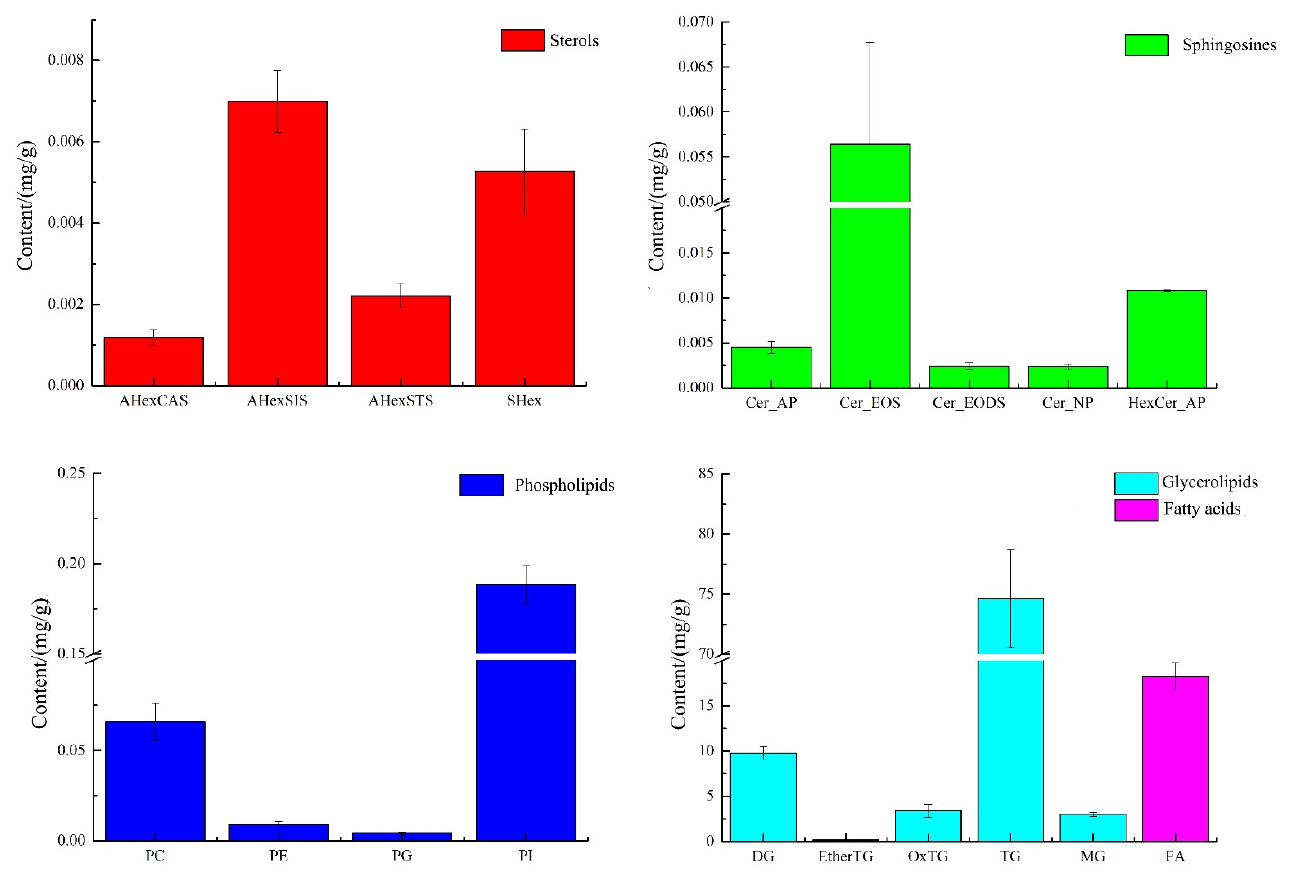
Figure 3. The composition of sterols, sphingosine, phospholipids, glycerides, and fatty acids in green coffee.